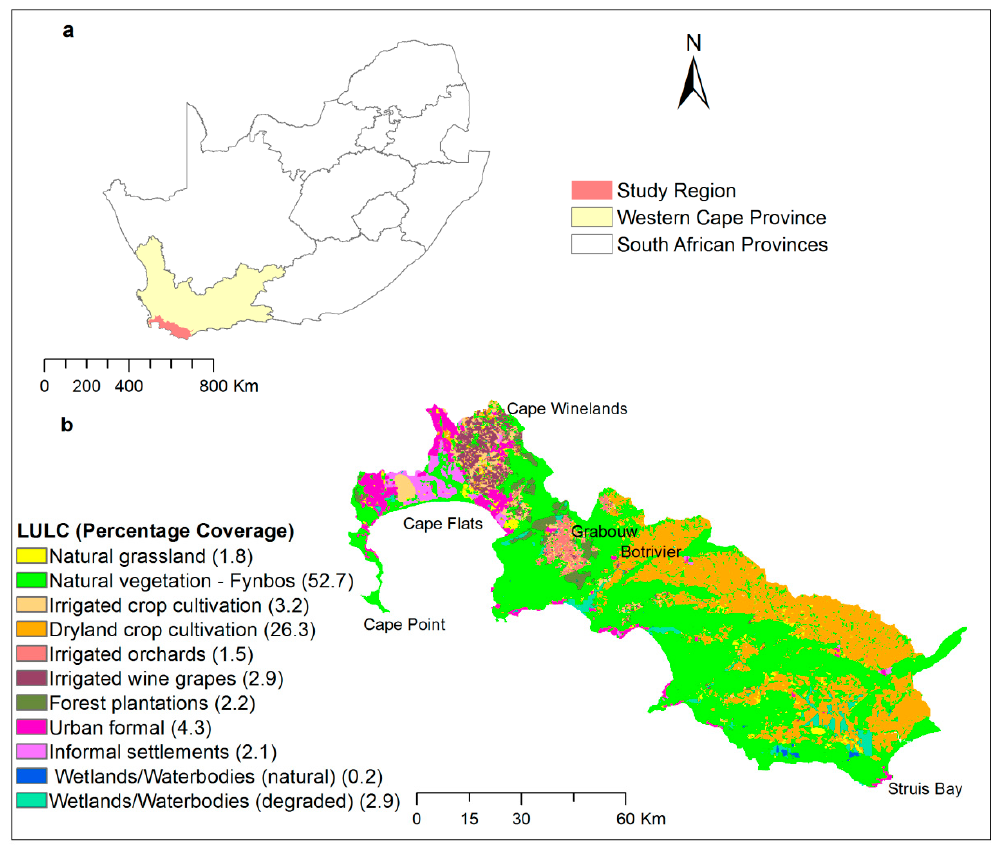
Figure 1. a . Location of the study regions along the southern coast, Western Cape Province, South Africa. b . Land use/land cover of the study region, including the percentage coverage of each class [26,27].